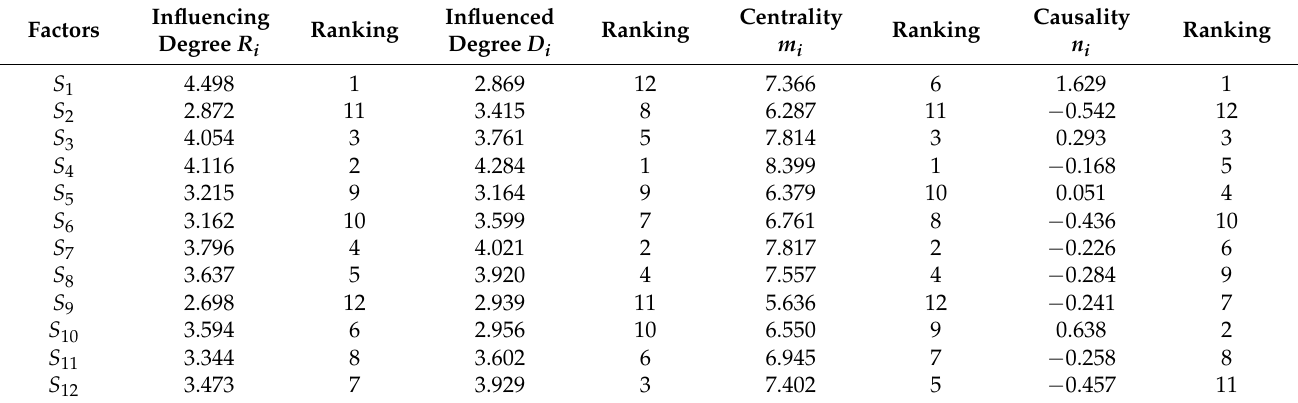
Table 5. Influencing degree, influenced degree, centrality and causality of factors.